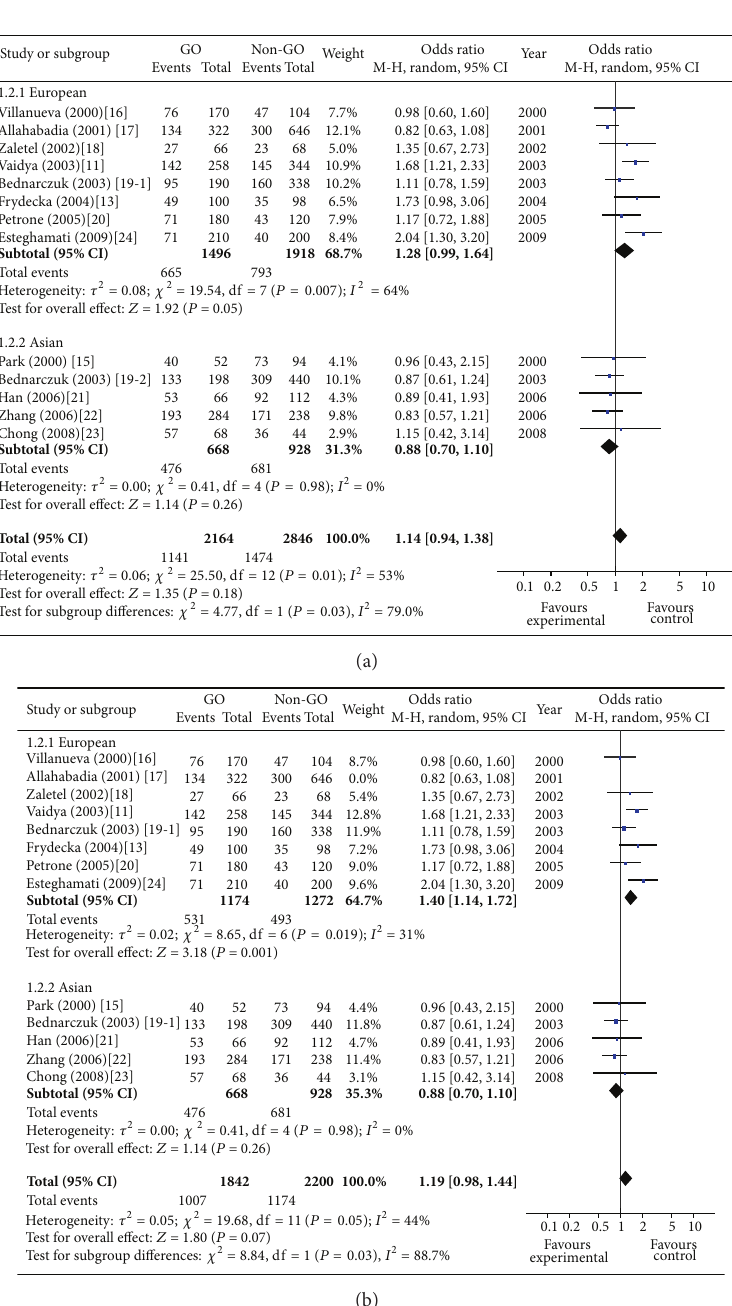
Figure 1: Meta-analysis for the effect of the G allele versus the A allele on the risk of GO in GD patients. Each comparison is presented by the name of the first author and the year of publication. The point estimate of the odds ratio and the accompanying 95% confidence interval (CI) are shown. “Total” represents the summary random effects estimation for the comparison along with the respective 95% confidence interval. Values above 1 denote an increased risk for GO with the G